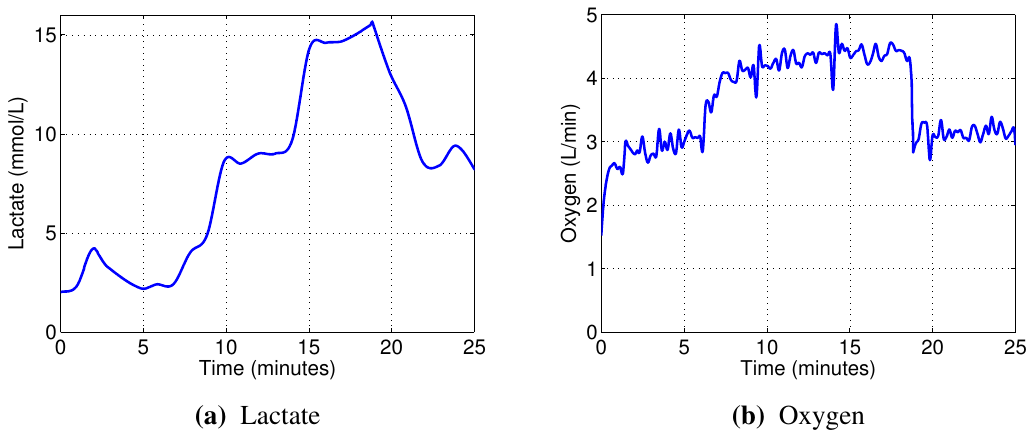
Figure 3. Physiological parameters over time for Subject 2. The graphs are interpolated; blood lactate concentration was measured every minute, and oxygen uptake was measured every 10